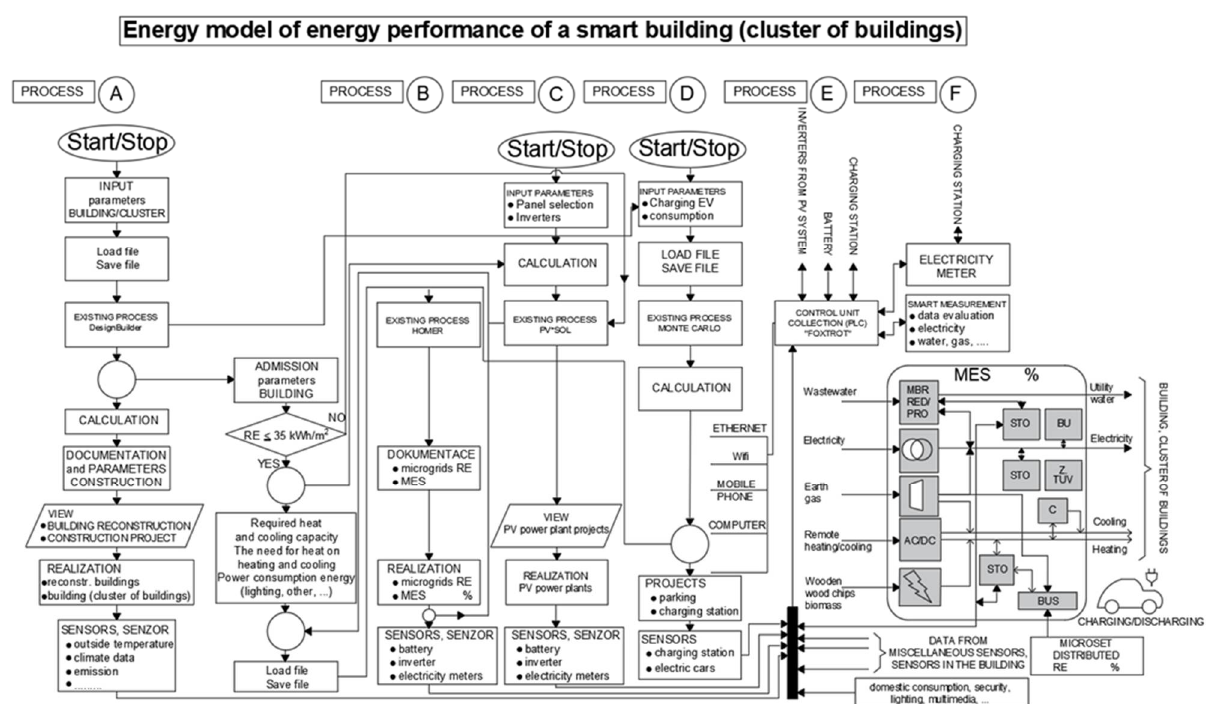
Figure 1. Energy model of a building: existing (current).